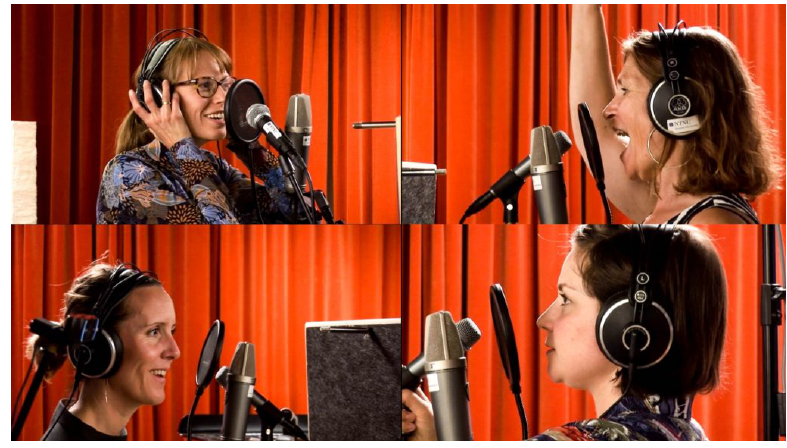
Figure 15. Session with singers from Trondheim Voices.